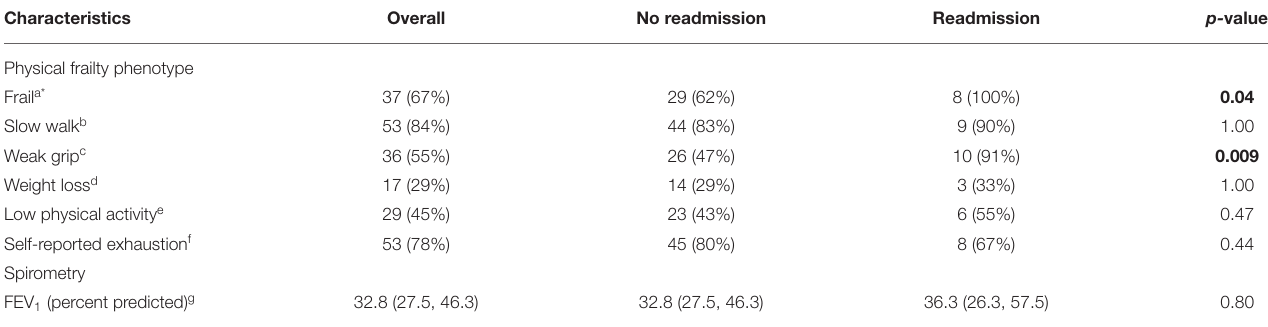
TABLE 2 | Univariable logistic regression predicting all-cause readmission at 30